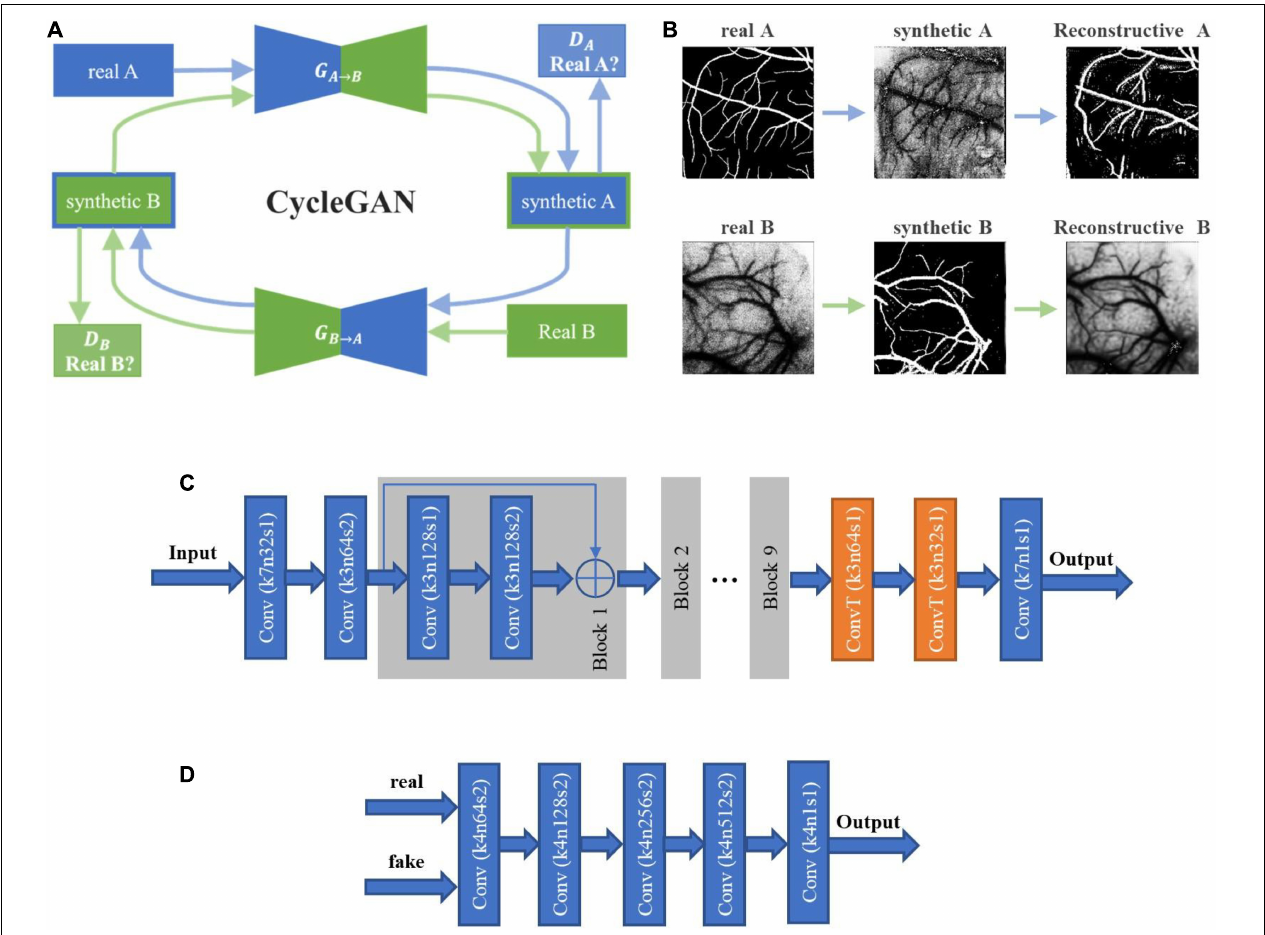
FIGURE 5 | The architecture of cycle-consistent GAN (CycleGAN) and the image flow. (A) CycleGAN contains two generators and two discriminators trained in an adversarial way, where the architectures of generator and discriminator are shown in Panels (C,D) . The first generator G A → B transforms images from domain A to domain B, and the discriminator D A is trained to distinguish synthetic images from real images. The objective is to make the discriminator unable to discriminate between real and synthetic data. Similarly, the second generator G B → A transforms images of domain B back to domain A, and the discriminator D B is trained to distinguish synthetic images from real images. The synthetic images should also be able to be transformed back to the original domain by the other generator, and the objective is to minimize the difference between the transformed images and the originals. (B) The image flow of CycleGAN. The upper panels represent the path from domain A to domain B, and the lower ones show the reverse path. In this study, domains A and B correspond to the fundus images and the laser speckle images, respectively. (C) The architecture of the generators G A → B and G B → A . (D) The architecture of the discriminators D A and D B .